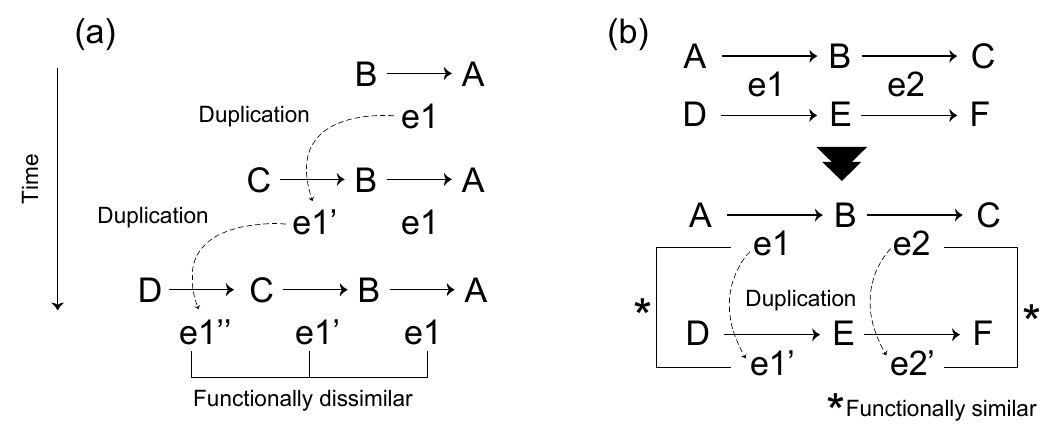
Figure 3. Schematic diagram of classical hypotheses in metabolic pathway evolution. ( a ) Retrograde evolution. Assuming that compound A is essential for survival and compound B is obtained from the external environment, survival is dependent on the existence of compound B in the environment. When compound B decreases due to perturbations, a new enzyme e1 ′ that can synthesize the compound B from compound C, which is more widely available in the environment, is acquired through gene duplication of the enzyme e1. ( b ) Patchwork evolution considers that the present metabolic pathway is obtained by substrate- specific specialization of ancestral enzymes with broad substrate specificities via gene duplication. Due to broad substrate specificities, the enzyme e1 (e2) catalyze both reactions between metabolites A and B (B and C) and between metabolites D and E (E and F) (the upper pathway). Though the duplication of e1 (e2), the enzyme e1’ (e2’) emerges. Due to substrate-specific specialization, the enzymes e1 (e2) and e1’ (e2’) catalyze the reaction between metabolites A and B (B and C) and the reaction between metabolites D and E (E and F), respectively (the lower